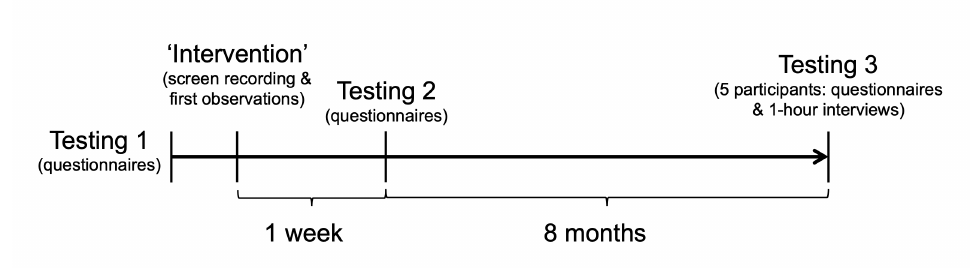
Figure 1: The three stages of